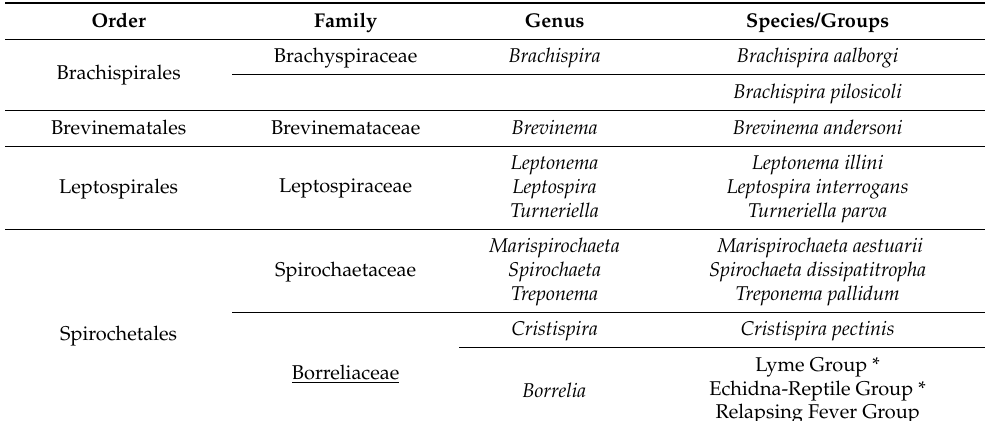
Table 1. Classification of bacteria of phylum Spirochaetes, class